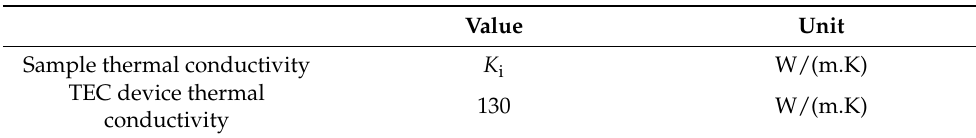
Table 2. Thermal parameter of material in the simulation. (The value of K i will change depending on if the sample is without or with HTC